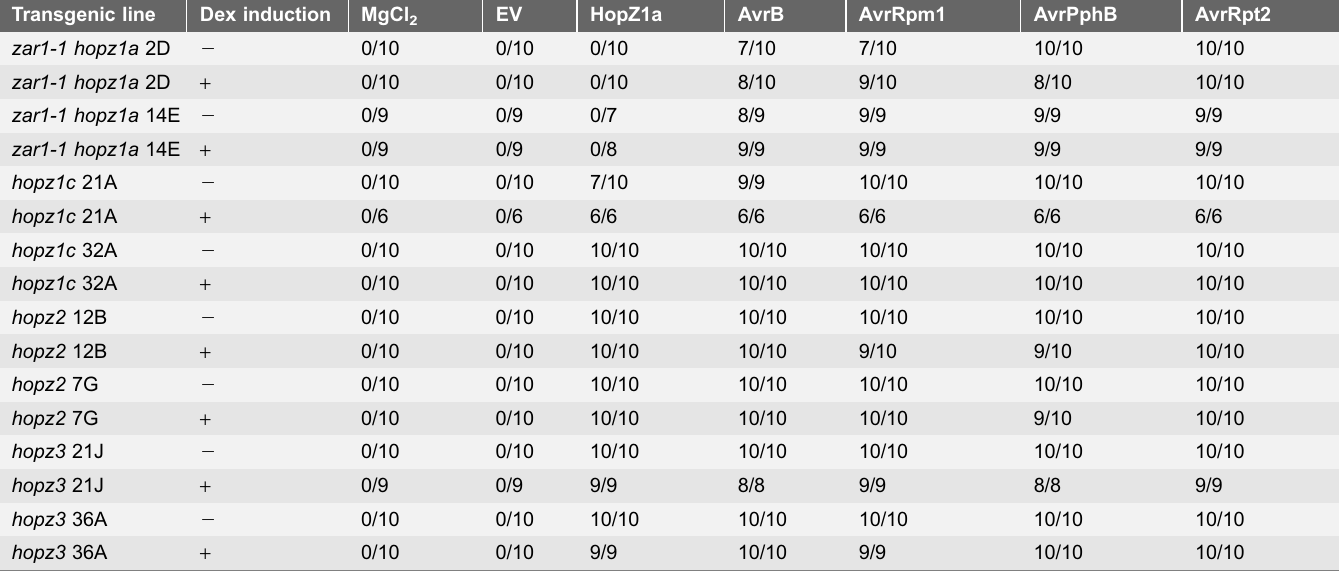
Table 1. Number of leaves showing an HR when infiltrated with Pto DC3000 carrying different recognized T3SEs in transgenic HopZ Arabidopsis lines. Transgenic